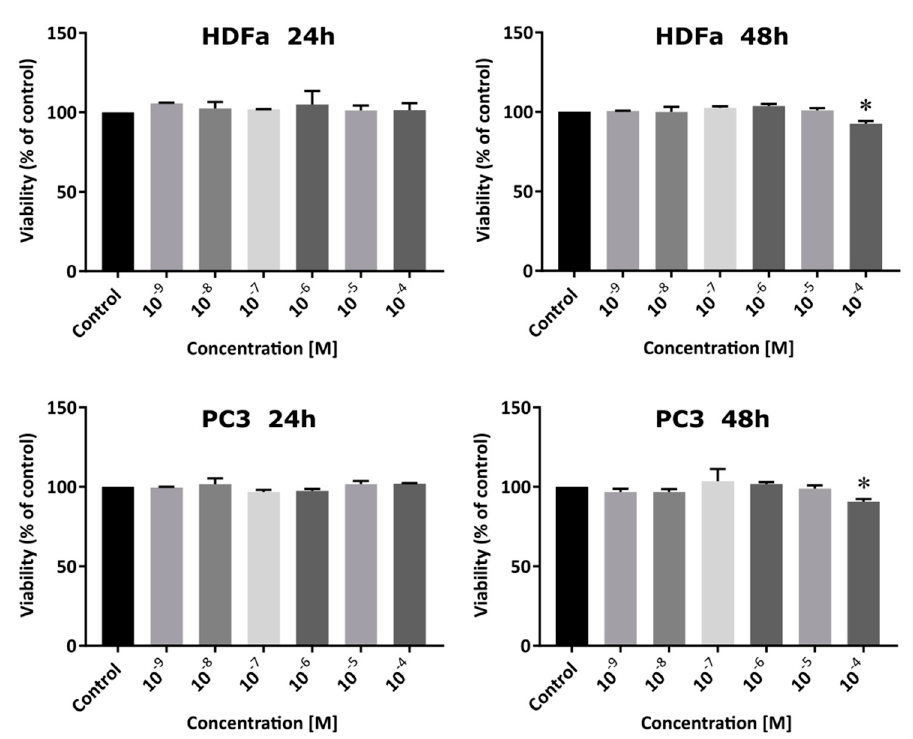
Figure 8. The viability of PC3 and HDFa cell lines after 24 and 48 h treatment with 5-( N -trifluoromethylcarboxy)aminouracil in a range of concentrations from 0 to 10 − 4 M. Results are shown as mean ± SD of three independent experiments performed in triplicate. * a statistically significant difference is present in the treated culture when compared with control (untreated culture).